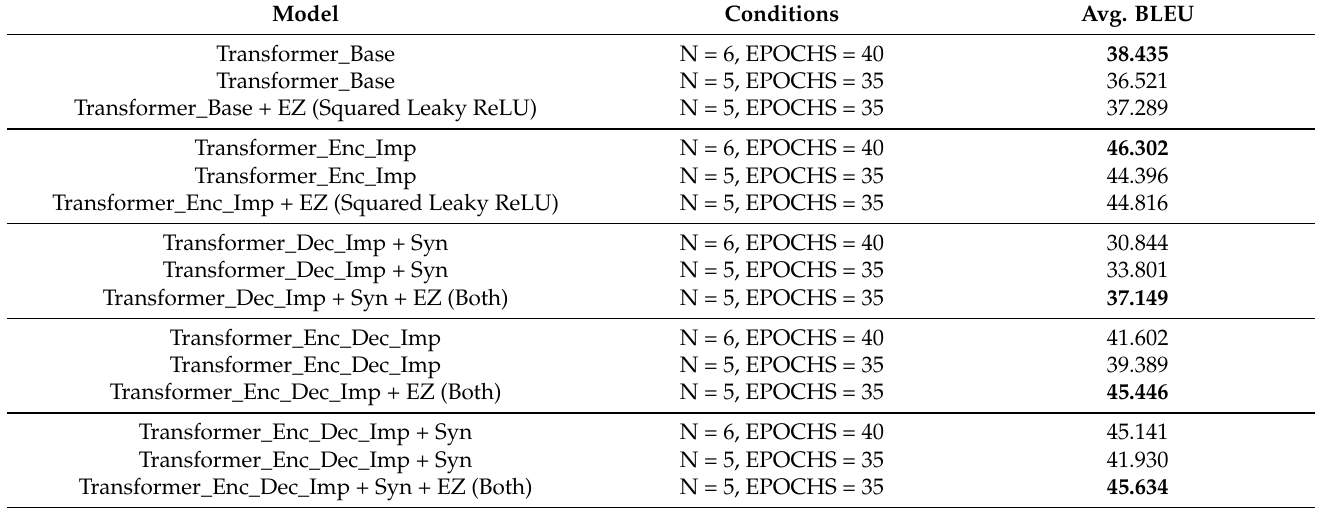
Table 7. The Traditional Mongolian-Chinese translation